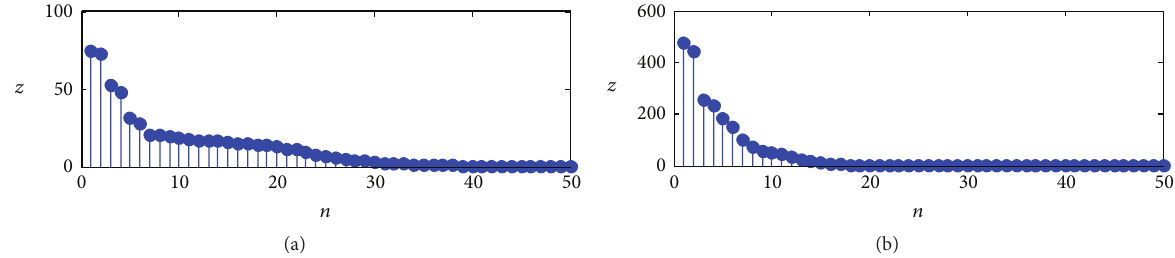
Figure 7: Singular values of IMF2 and IMF3 based on SVD. (a) Singular values of IMF2. (b) Singular values of IMF3.